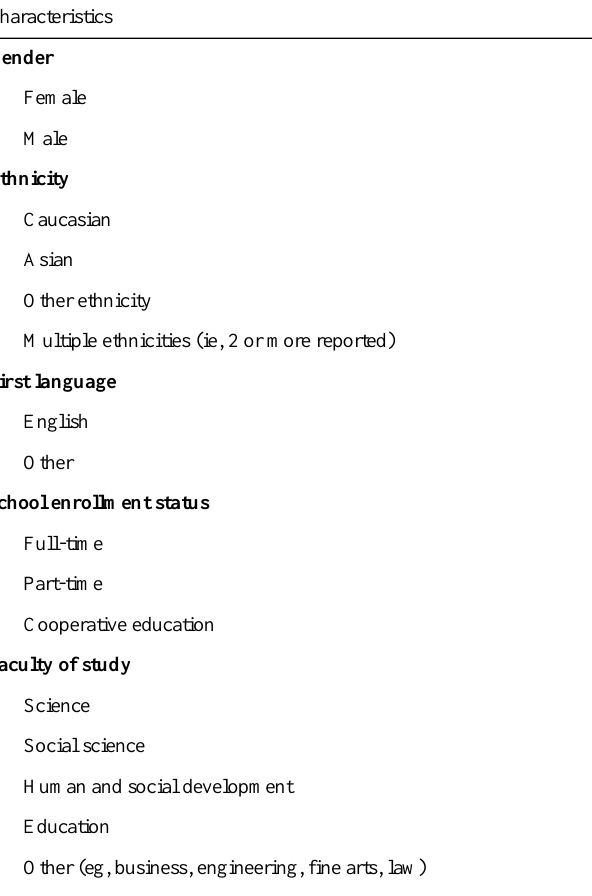
Table 1. Participants’characteristics